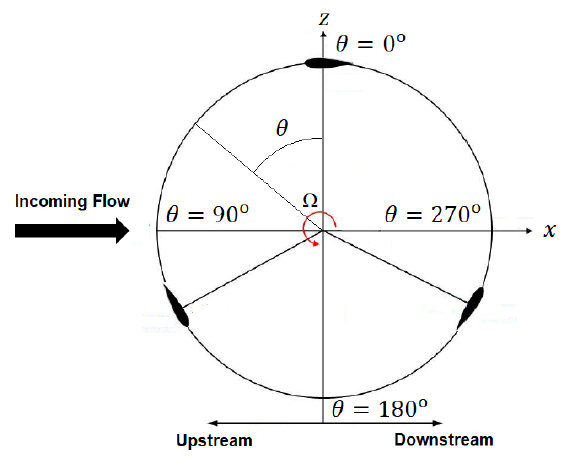
Figure 4. Coordinate system employed to describe the counterclockwise rotation of the blades and azimuth angle θ . Incoming flow progresses from left to right.